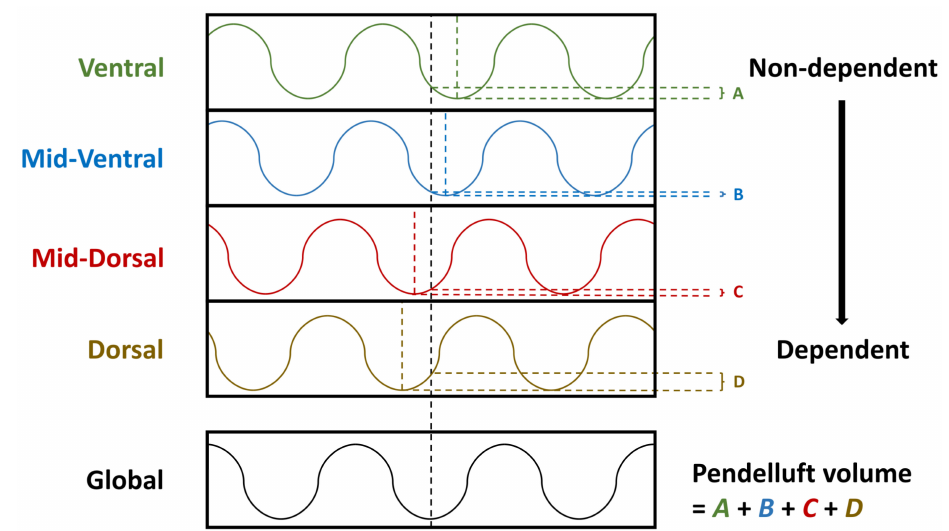
Figure 2. The quantitative analysis of pendelluft. The global impedance–time curve is presented in the bottom column and the timepoint of nadir impedance was recognized as the starting point of inspiration (black dash line). The impedance–time curve of each region of interest is presented in the upper column, and the timepoints of nadir impedance were also defined, including ventral (green dash line), mid-ventral (blue dash line), mid-dorsal (red dash line), and dorsal (brown dash line) parts. The impedance difference of each region between the global and regional nadir timepoints were calculated and summed as the pendelluft volume.